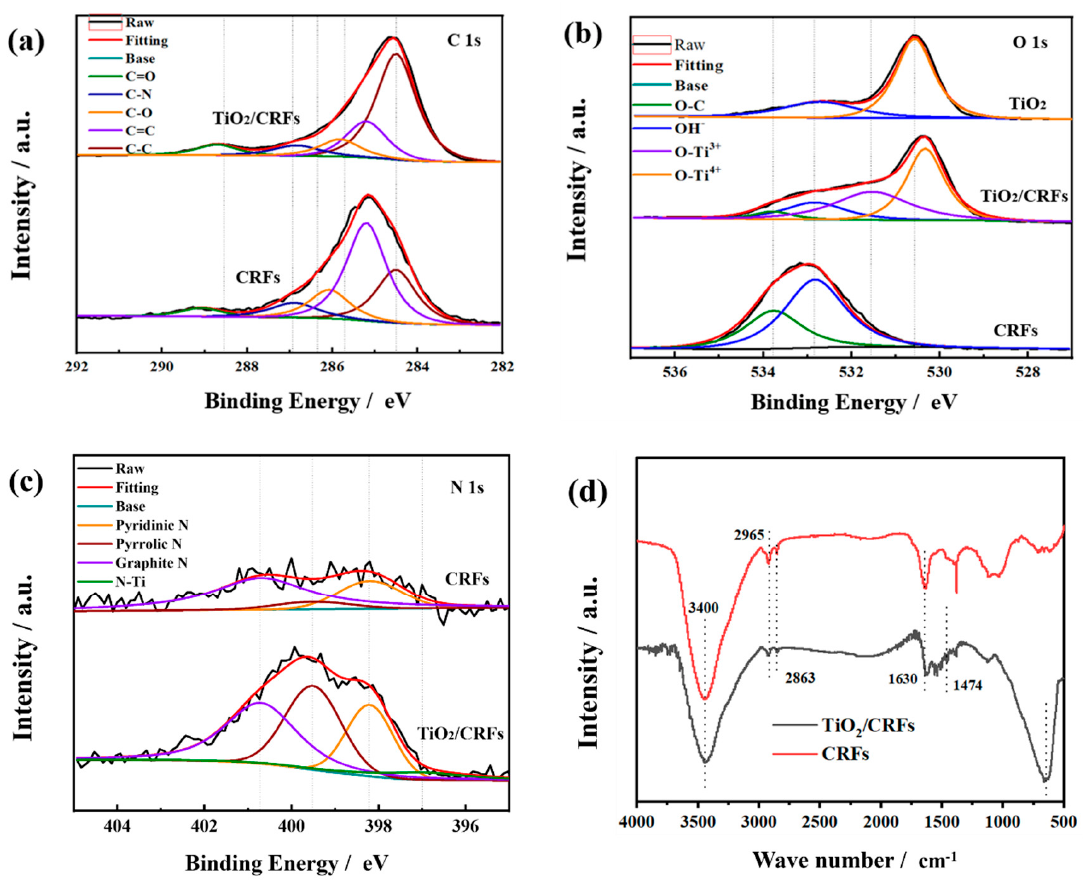
Figure 7. ( a – c ) XPS spectra of CRFs and TiO 2 /CRFs: ( a ) C 1s, ( b ) O 1s, ( c ) N 1s. ( d ) FTIR spectra of CRFs and TiO 2 /CRFs.